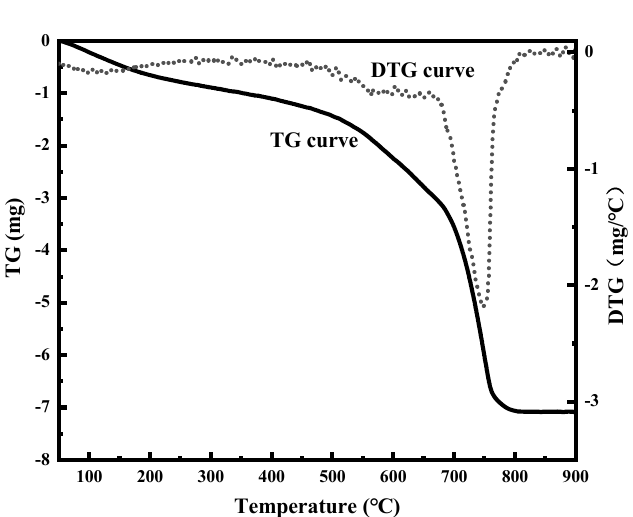
Figure 5. TG and DTG curves of the carbonated EAF slag.